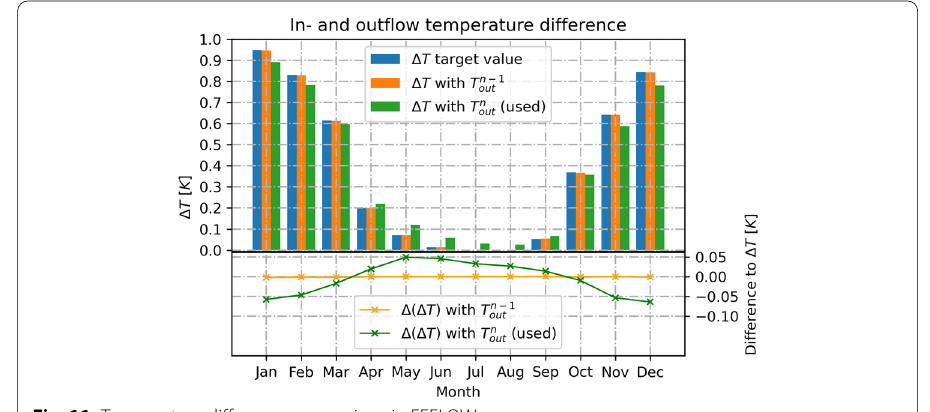
Fig. 11 Temperature difference comparison in